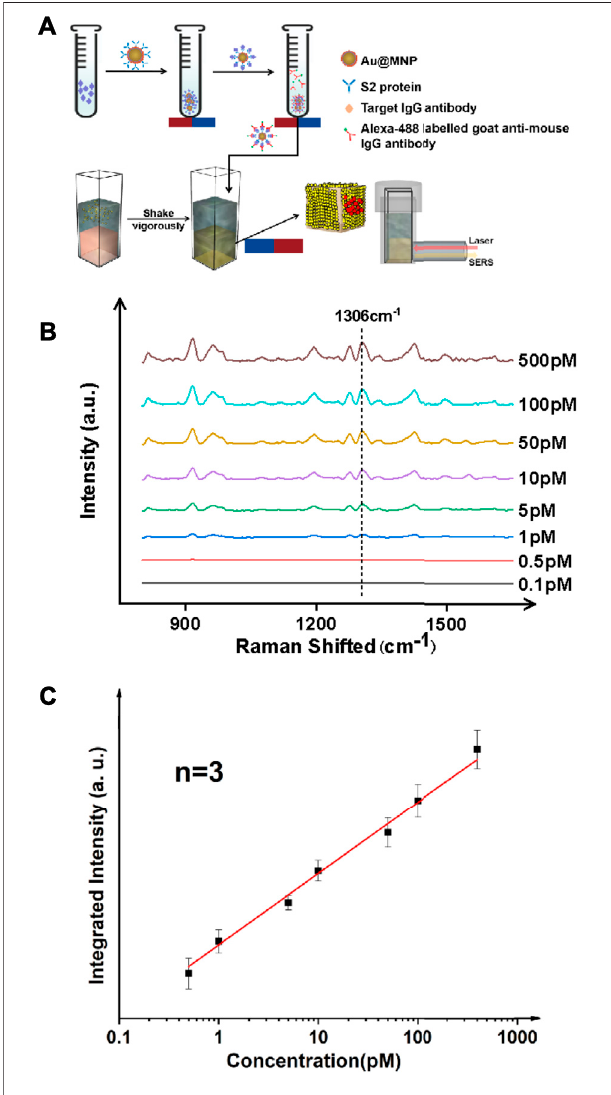
FIGURE 2 | Ultrasensitive detection of protein targets (IgG antibody) in a typical sandwich assay format. (A) Schematic illustration of the antibody detection process. The antigen here isthe IgG antibody which iselevated in the serumofpatientswithCOVID-19.AnS2proteinfragmentwasusedasthe primary antibody, and an Alexa 488 dye labeled anti-IgG antibody was used as thesecondaryantibody. (B) SERSspectrafortargetsofvariousconcentrations. (C) Linear trend showing a detection limit of IgG down to ∼ 1